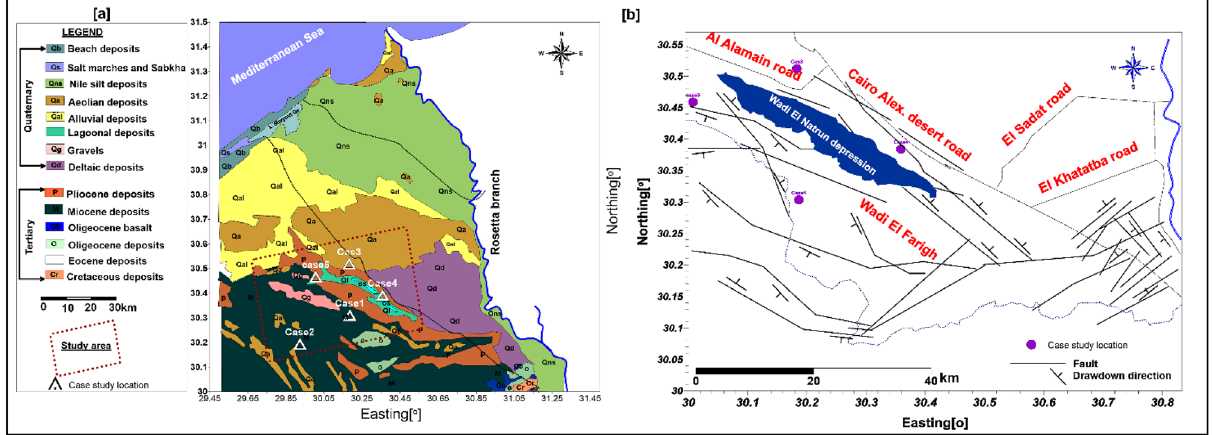
Figure 3. ( a ) Geological map of the study area (after 19 ), ( b ) Structural map of the study area (after 20 ).